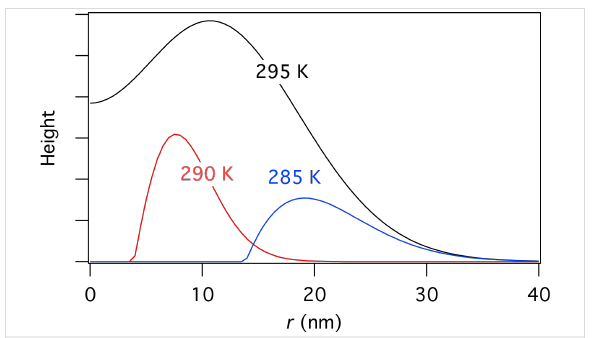
Figure 18: Deposit geometries analogous to those shown in Figure 11b, simulated using Equation 70 and Equation 71, a Gaussian electron-beam profile ( Ω = 5 nm) and substrate temperatures of 285, 290 and 295 K. (Etch species “e” = H 2 O, deposition species “d” = C 10 H 22 , f 0 = 6 × 10 4 Å − 2 s − 1 , P e = 1 Torr, P d = 0.01 Torr, E e = 0.56 eV, E d = 1.0157 eV, σ β = σ γ = 1 Å 2 , T g = 300 K. All other model input parameters were the same as in